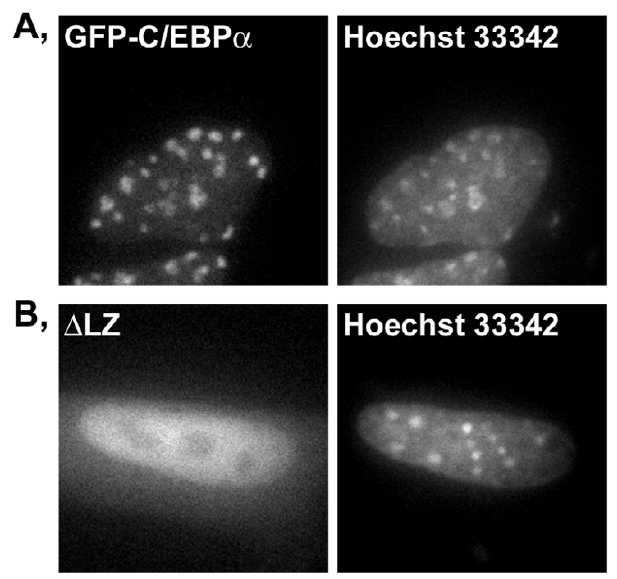
Figure 5 A, GFP-C/EBP or, B, GFP-C/EBP deleted of amino acids 310 to 358 ( ∆ LZ) were expressed in GHFT1-5 cells. The ∆ LZ construct is depicted in figure 1B. The transfected cells were counter-stained with the blue fluorescent, DNA-binding dye Hoechst 33342 immediately before analysis by fluorescence microscopy. Green fluorescent (left panels) and blue fluores- cent (right panels) images were collected from a single cell using filter sets that selectively discriminate GFP and Hoechst 33342 fluorescence (see Materials and Methods). The subnu- clear position of GFP-C/EBP α and ∆ LZ were compared to the subnuclear position of the peri-centromeric chromatin stained by Hoechst 33342. Representative images are